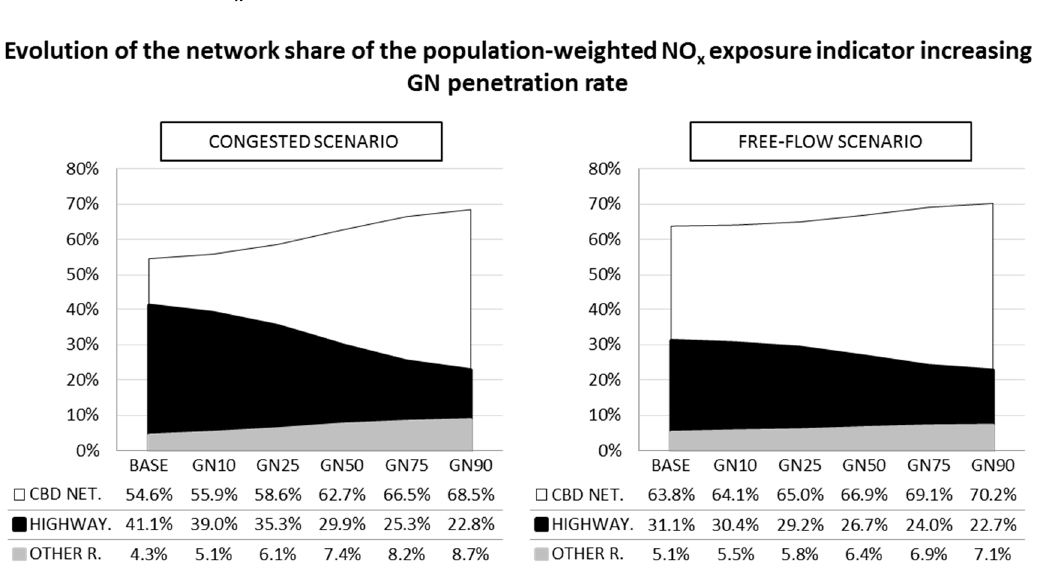
Figure 5. Evolution of the population exposure to the NO x indicator for different GN penetration rates and road types.